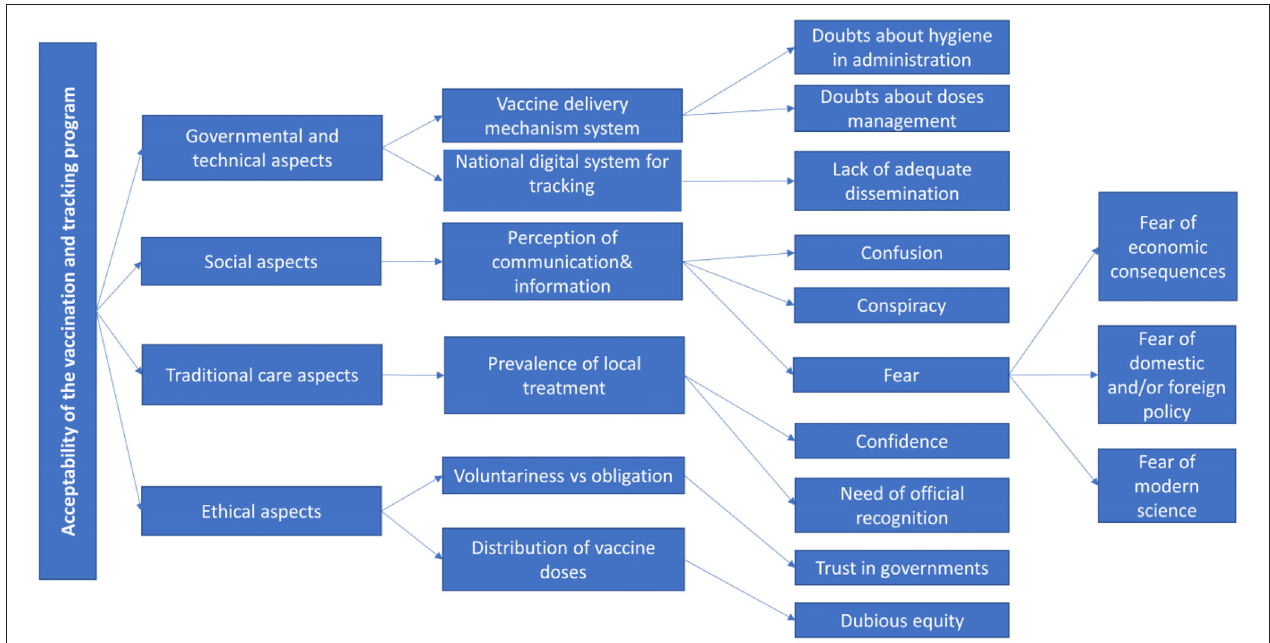
FIGURE 1 | Tree diagram highlighting the main themes surfacing from the